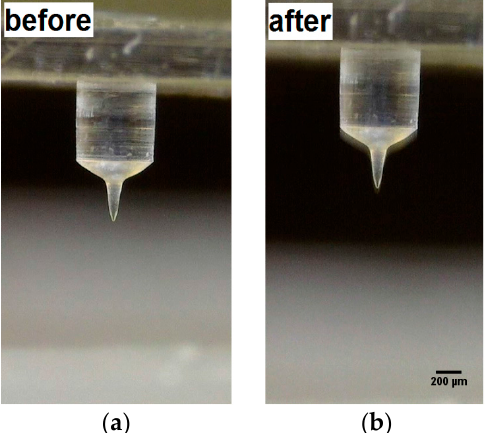
Figure 6. Microneedle obtained by electro-drawing of emulsion containing maltose ( a ) before and ( b ) after indentation in paraffin wax.